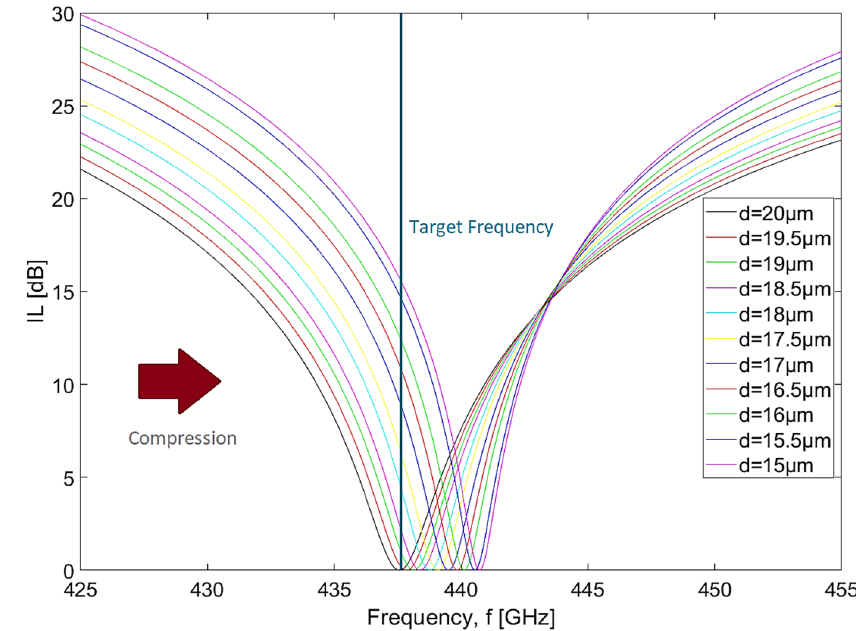
Figure 8. Insertion loss in the frequency domain as a function of applied compression for PTFE host